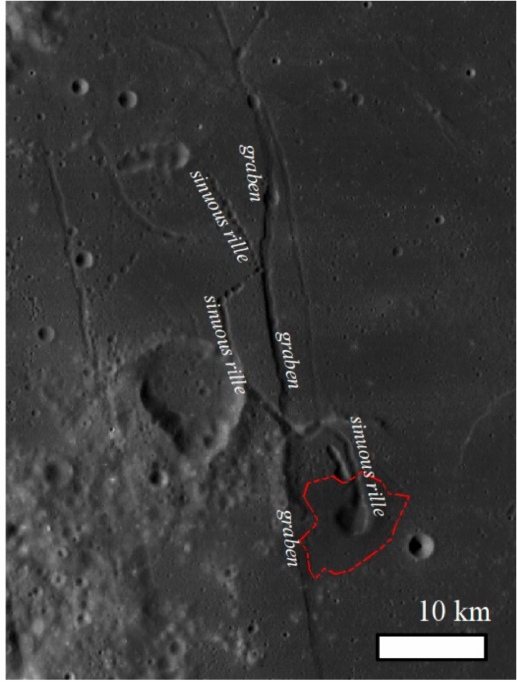
Figure 6. Sinuous rille, graben, and pyroclastic deposits (red dotted outline) in western Mare Fecunditatis (2.5 ◦ S, 42.0 ◦ E), shown with a WAC